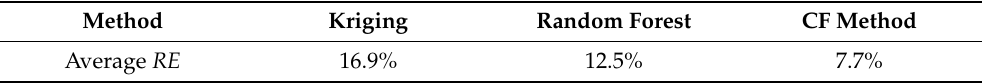
Table 4. The combination of RE of the CF method and conventional